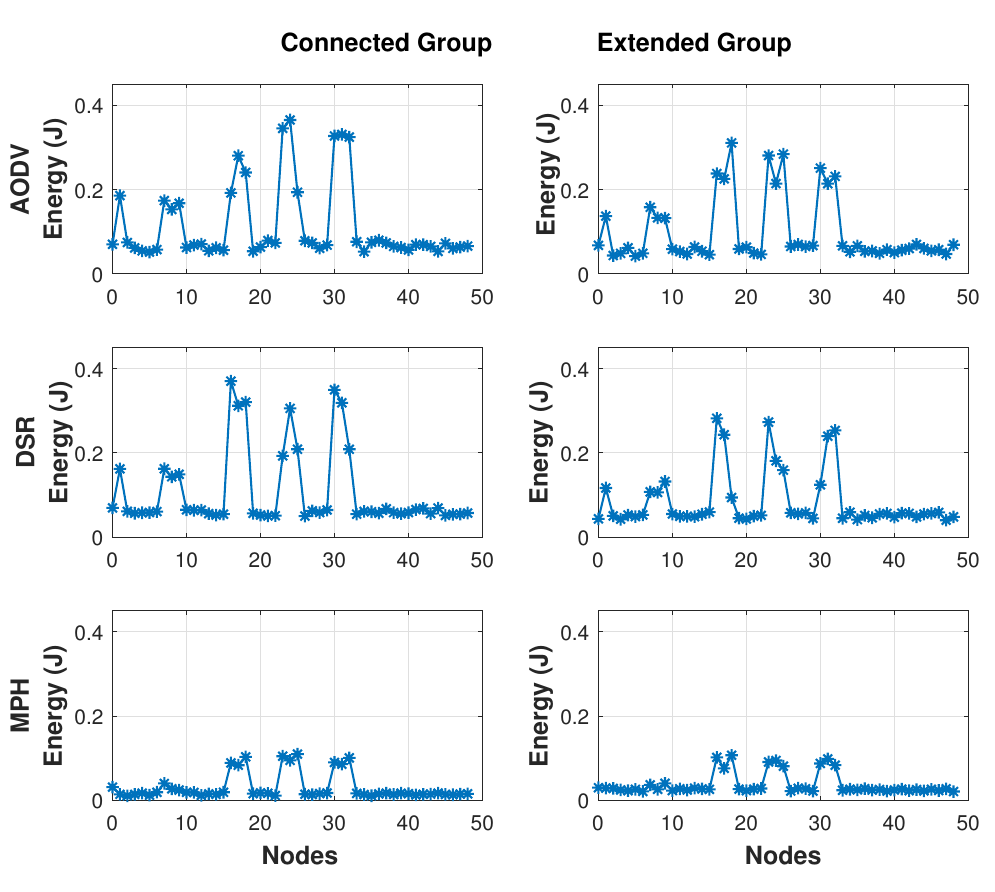
Figure 9. Energy per node under each